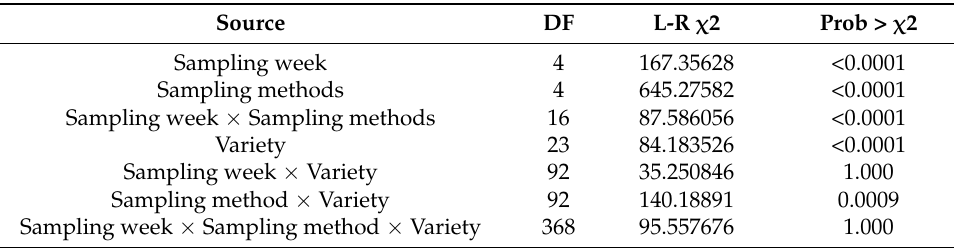
Table 2. Mixed model analysis for sampling method, sampling week, and cowpea varieties on abundance of